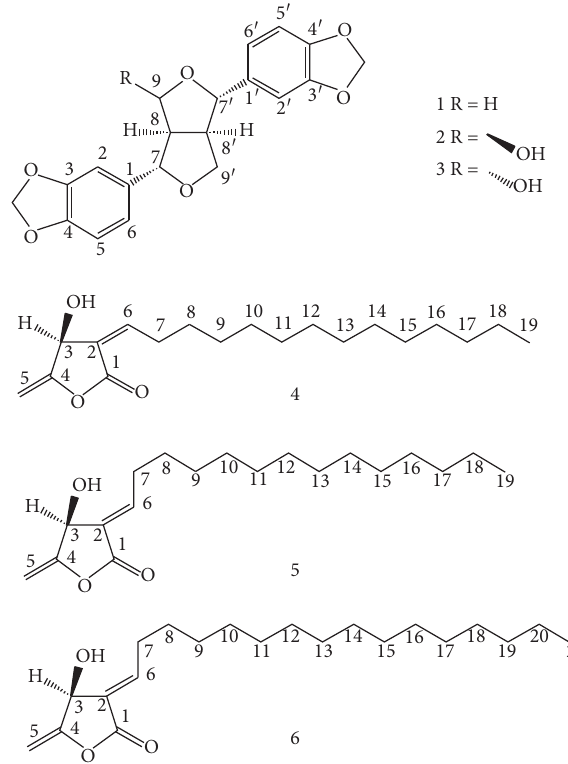
Figure 1: Chemical structures of compounds 1–6.